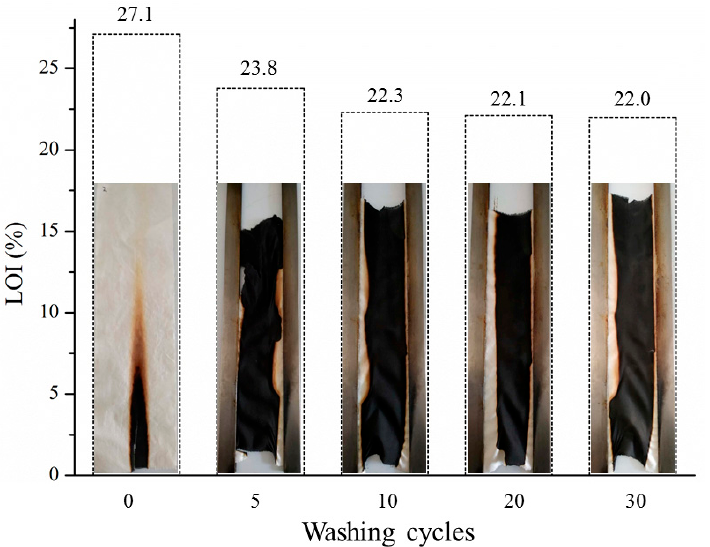
Figure 9. VFT pictures and LOI values of Cotton-PDTSP-2T against different washing